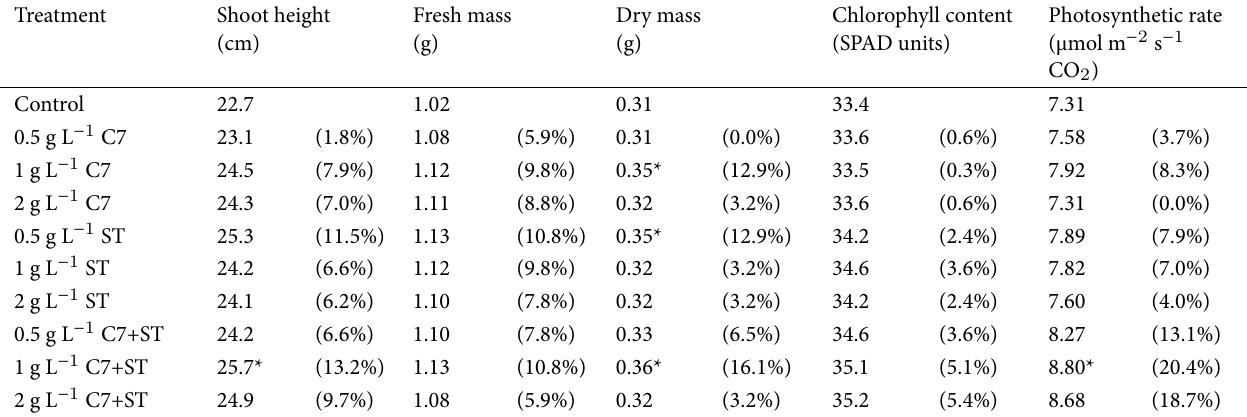
Table 1 Effect of Celext 07 (C7) and Stimulagro (ST) on soybean at fifteenth day after sowing using SOP-Soybean. Treatment